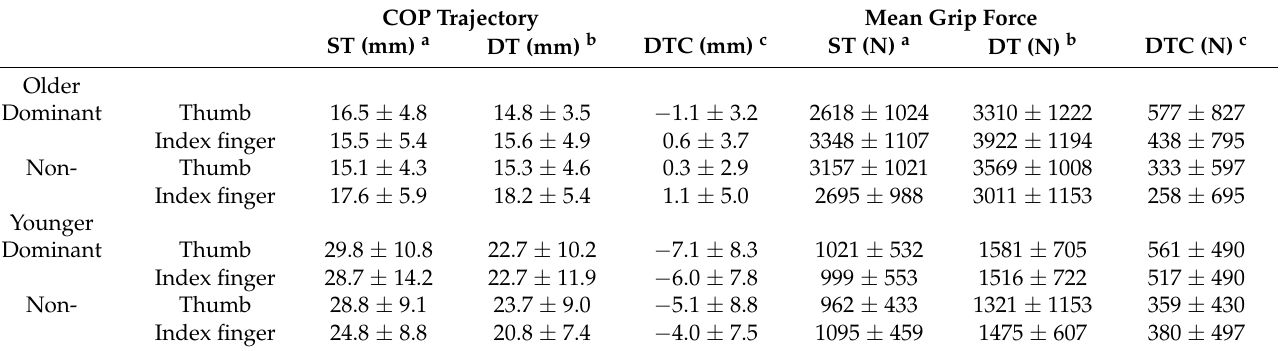
Figure 2. The trajectories of the center of pressure ( A ) and the traces of grip force ( B ) for typical subjects. The contact area of the fingertips is shown in blue, and the trajectory of the COP is shown by a gray line in ( A ). Table 2. Mean value of kinetic parameters and dual task costs.